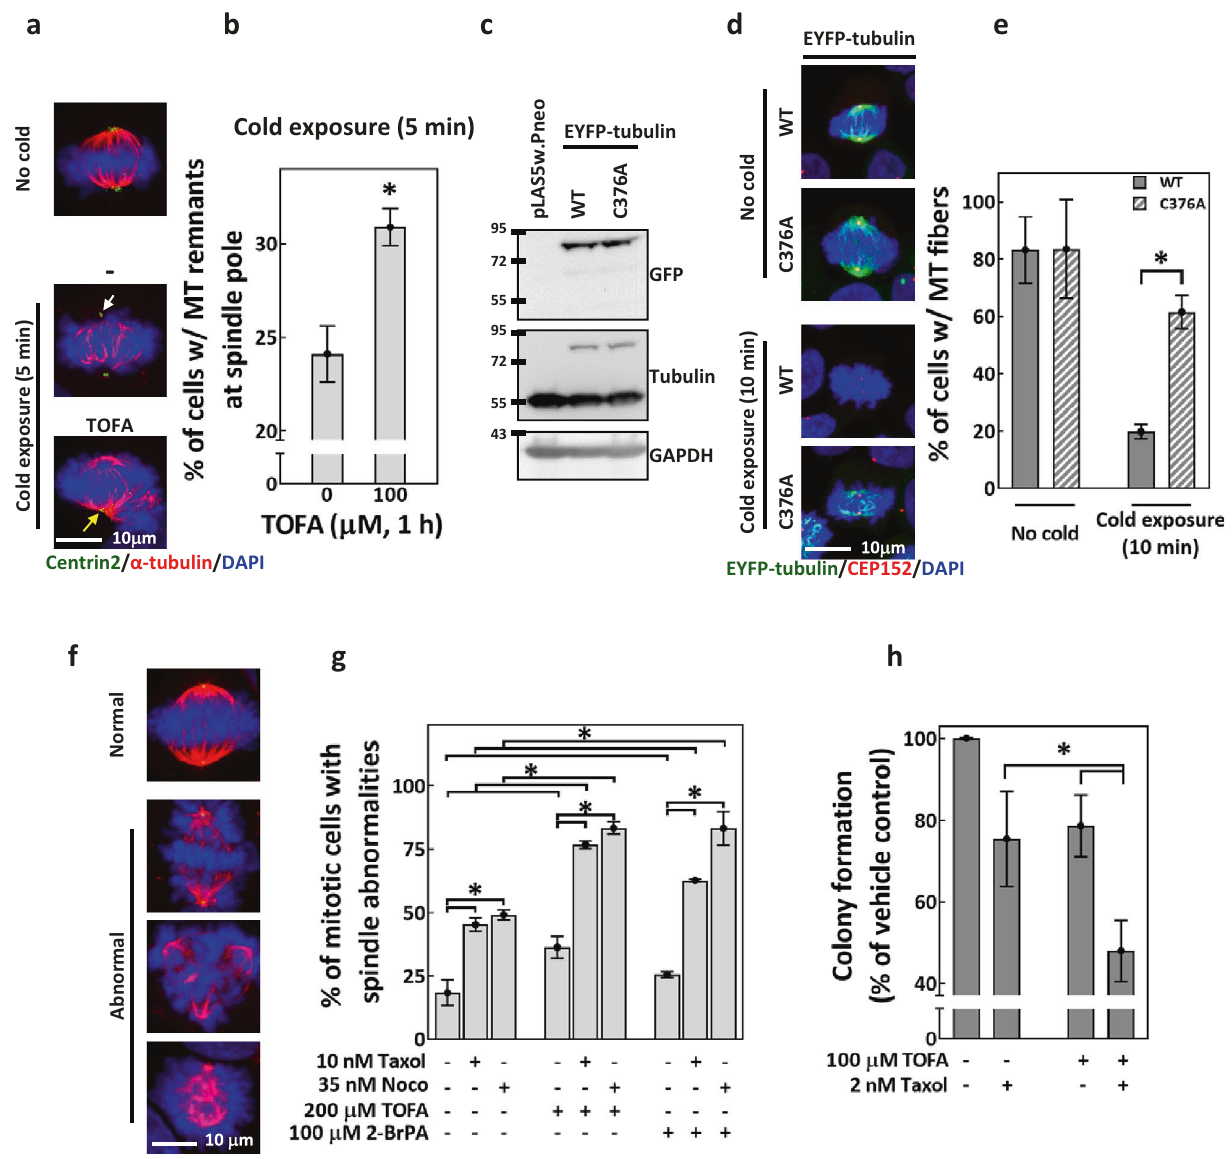
Fig. 6 TOFA and palmitoylation-de fi cient tubulin alter MT dynamic instability. a , b TOFA hampered cold-induced MT disassembly at the SP. a Representative images of cells subjected to cold exposure. Cells were untreated ( − ) or pretreated for 1 h with 100 μ M TOFA, followed by 5 min cold exposure before fi xation and staining for centrin2 (green), α -tubulin (red), and DAPI (blue). Cells fi xed without cold exposure (No cold) served as the control. The white arrow indicates the site of MT disassembly at the SP, and the yellow arrow indicates the site where MT remnants were observed at the SP after cold exposure. b Percentages of untreated or TOFA-pretreated CGL2 cells with MT remnants at the SP after 5 min cold exposure. Mean ± SD from three independent experiments is shown. * P < 0.05 by Student ’ s t test. c – e C376A mutation on α - tubulin renders spindle MTs resistant to cold-induced disassembly. c Western blots show the expression ef fi ciency of EYFP-tubulin-WT and -C376A in HeLaS3 cells. Cells transduced with empty vector pLAS5w.Pneo served as the control. d Representative images of EYFP-tubulin-WT- or C376A-expressing cells subjected to 10 min cold exposure, fi xation, and staining for CEP152 (red) and DAPI (blue). MT fi bers of EYFP-tubulin are displayed in green. Cells fi xed without cold exposure (No cold) served as the control. e Percentages of the cells described in ( d ) that exhibit MT fi bers with EYFP-tubulin-WT and -C376A. Mean ± SD from two independent experiments is shown. * P < 0.05 by Student ’ s t test. f Representative image of the normal and abnormal mitotic spindles. Cells were stained for CEP152 (green), α -tubulin (red) and DAPI (blue). g TOFA and 2-BrPA enhanced taxol- and nocodazole-induced spindle abnormalities. CGL2 cells were treated for 4 h with TOFA or 2-BrPA, alone or in combination with 0.5-h treatments of taxol or nocodazole as indicated. Treated cells were fi xed and stained for spindle analysis. Percentages of cells with abnormal spindles (as in f ) are shown as mean ± SD of at least 600 cells from two independent experiments. * P < 0.05 by Student ’ s t test. h TOFA enhanced taxol-induced cytotoxicity. MDA-MB-231 cells were treated with TOFA and taxol for 24 h, alone or in combination as indicated. Treated cells were subjected to colony-formation assay. Percentages of colonies formed compared to the vehicle control are shown as mean ± SD from six independent experiments. * P < 0.05 by Student ’ s t test.